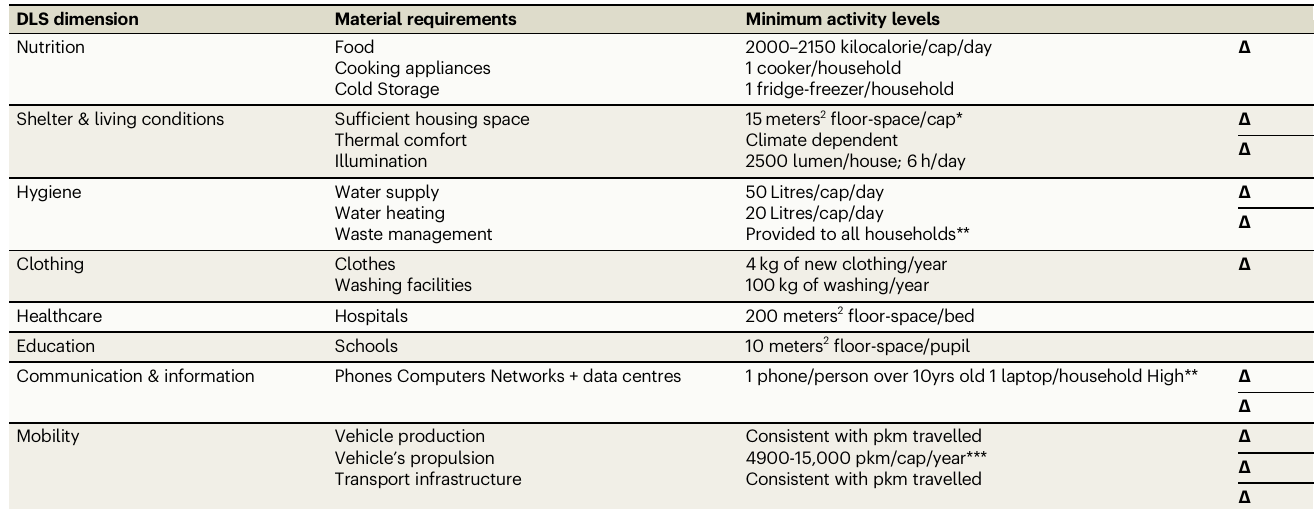
Activitylevelslistedarethoseassumedfordecentlivingstandards(DLS)intheDLEmodel 22 ,butinthethreeinequalityscenariosdevelopedhere,levelsarevariedforthecategoriesindicatedbythe triangles( Δ ) in the right-handcolumn(notethat forfood, kcal/day are fi xed andGJ/kcal modi fi ed instead; see Supplementary Information).** *Assuming 10m 2 of living space/capitaplus20m 2 of communal space per 4-person household. ***Activity levels here arenot straightforward to de fi ne. ***Large rangeas this varies with regionalpopulationdensity.